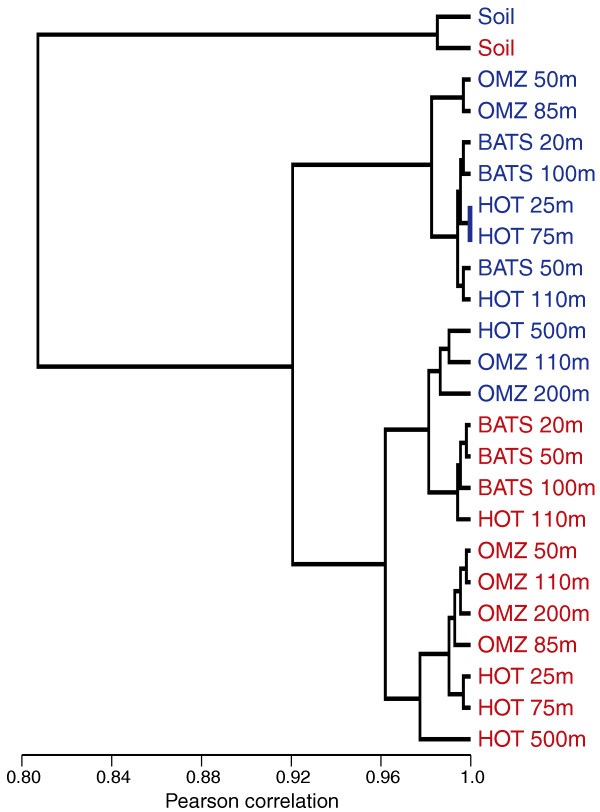
Relatedness of DNA (blue) and RNA (red) datasets as determined by amino acid proportions. Dendrograms are based on hierarchical clustering of Pearson correlation coefficients for each pairwise comparison of amino acid proportions.